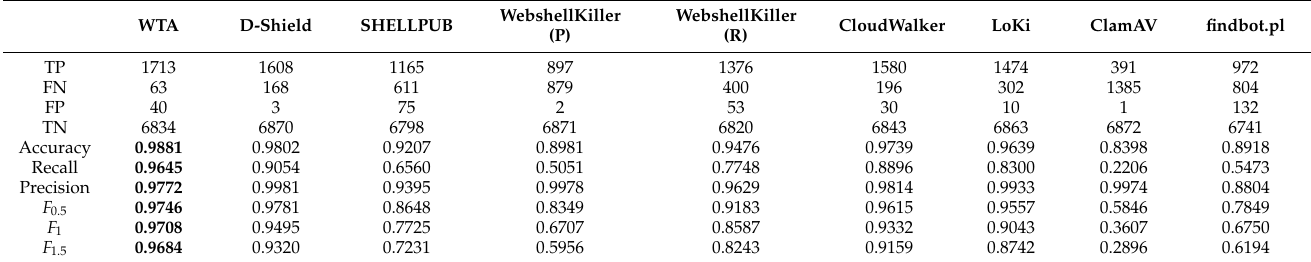
Table 10. Comparison of the webshell detection